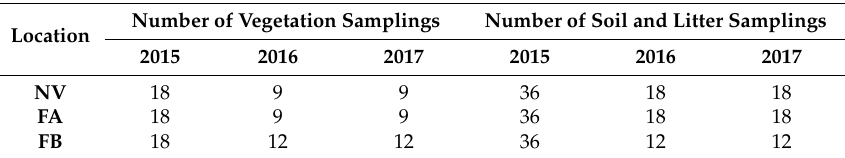
Table 3. Number of vegetation transects and soil and litter samplings before and after harvesting at each